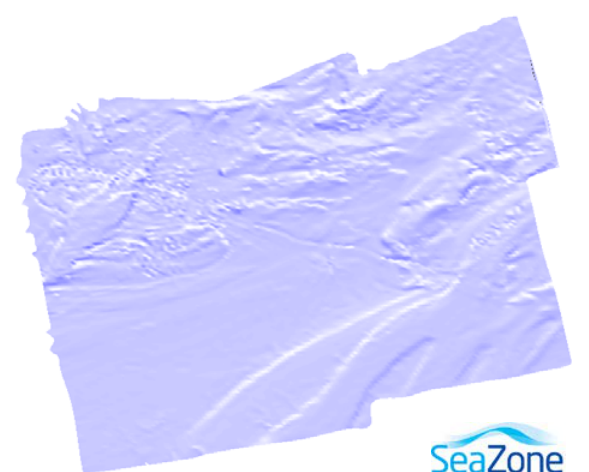
Figure 4: An LR B-spline surface approximation of the HRW combined bathymetry data set with tolerance 0.5 m and maximum iteration levels six.